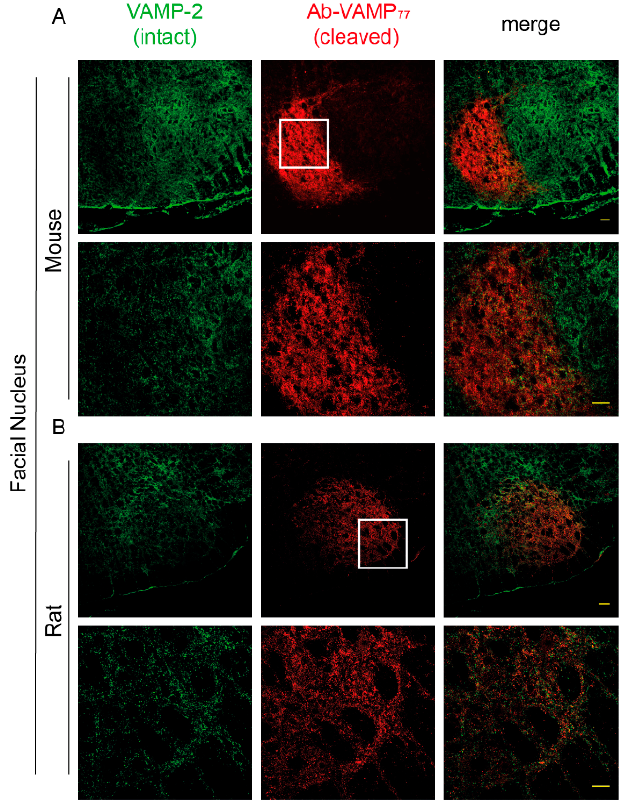
Figure 4. The Ab-VAMP 77 polyclonal antibody detects VAMP cleavage by TeNT in the brain stem. The TeNT was injected either at the level of the LAL in the mouse ( A ) or at the level of the whisker pad in rats ( B ) and then the cleavage of VAMP was evaluated in the brain stem with an antibody against intact VAMP-2 (green) and Ab-VAMP 77 (red). The bottom panels in ( A , B ) show a magnification of the white-squared area. Scale bar = 40 µm